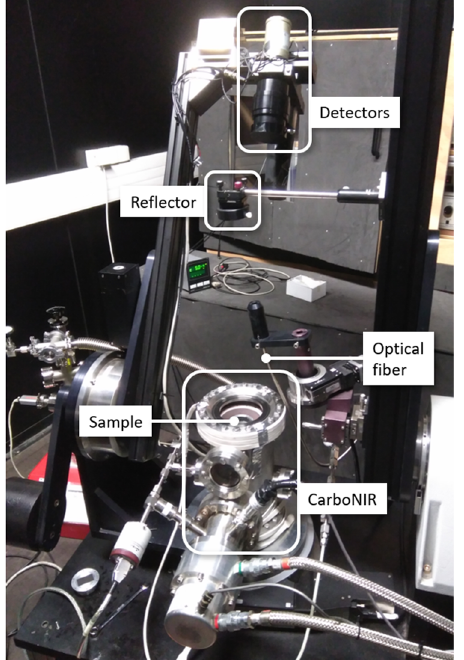
Fig. 9 Setup of the sublimation experiment: The SHINE spectro-gonio radiometer with the icy sample inside the CarboNIR environmental chamber. Light originating in a monochromator (not visible) is led through an optical fi bre to a re fl ector to illuminate the sample at 0° incidence angle. Detectors at the end of an arm of SHINE captures light re fl ected by the sample at an angle of 30°.